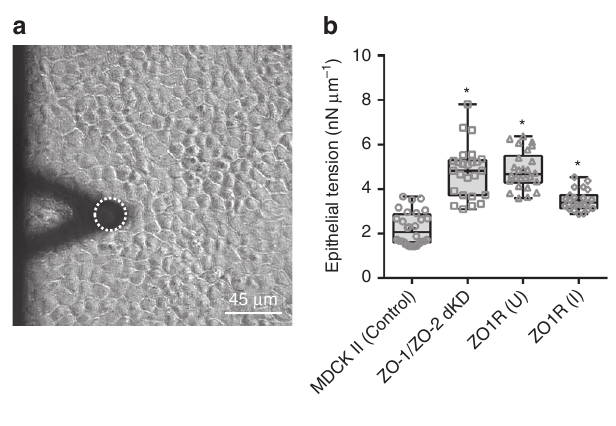
Fig. 3 Alterations of tight junctions structure by depletion of ZO-1 and ZO-2 elevates polarized epithelial tension. a Phase contrast image showing the AFM cantilever with microbead (dashed circle) and the MDCK II polarized monolayer. b In ZO-1/ZO-2 dKD in MDCK II Tet-off cells the apical surface epithelial tension dramatically increases. In ZO1R(U) dKD cells the apical surface epithelial tension is signi fi cantly elevated when compared to control, but the tension is partially restored when ZO1R(I) dKD cells are expressing a Tet-inducible full-length ZO-1 rescue transgene. U, ( + dox, uninduced); I, ( − dox, induced). Data are represented as mean ± s.d.; * indicates signi fi cant difference in comparison with control P < 0.05 (unpaired two-tailed Student ’ s t -test with Welch ’ s correction); number of measurements pooled for 2 – 3 independent experiments for each condition, n = 28, 25, 26, and 23 for control, ZO-1/ZO-2 dKD, ZO1R(U), and ZO1R(I),